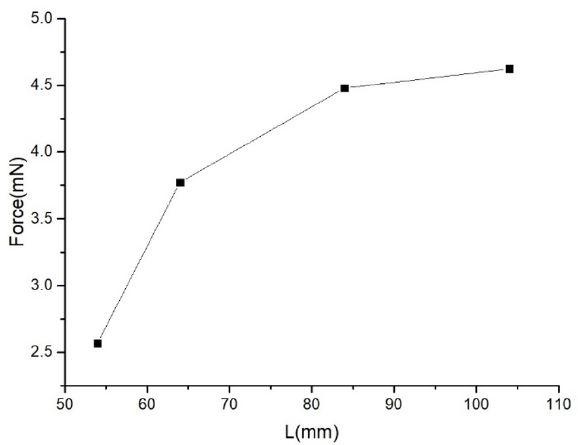
Fig. 11. Influence of shaft core length on stress of shaft core.